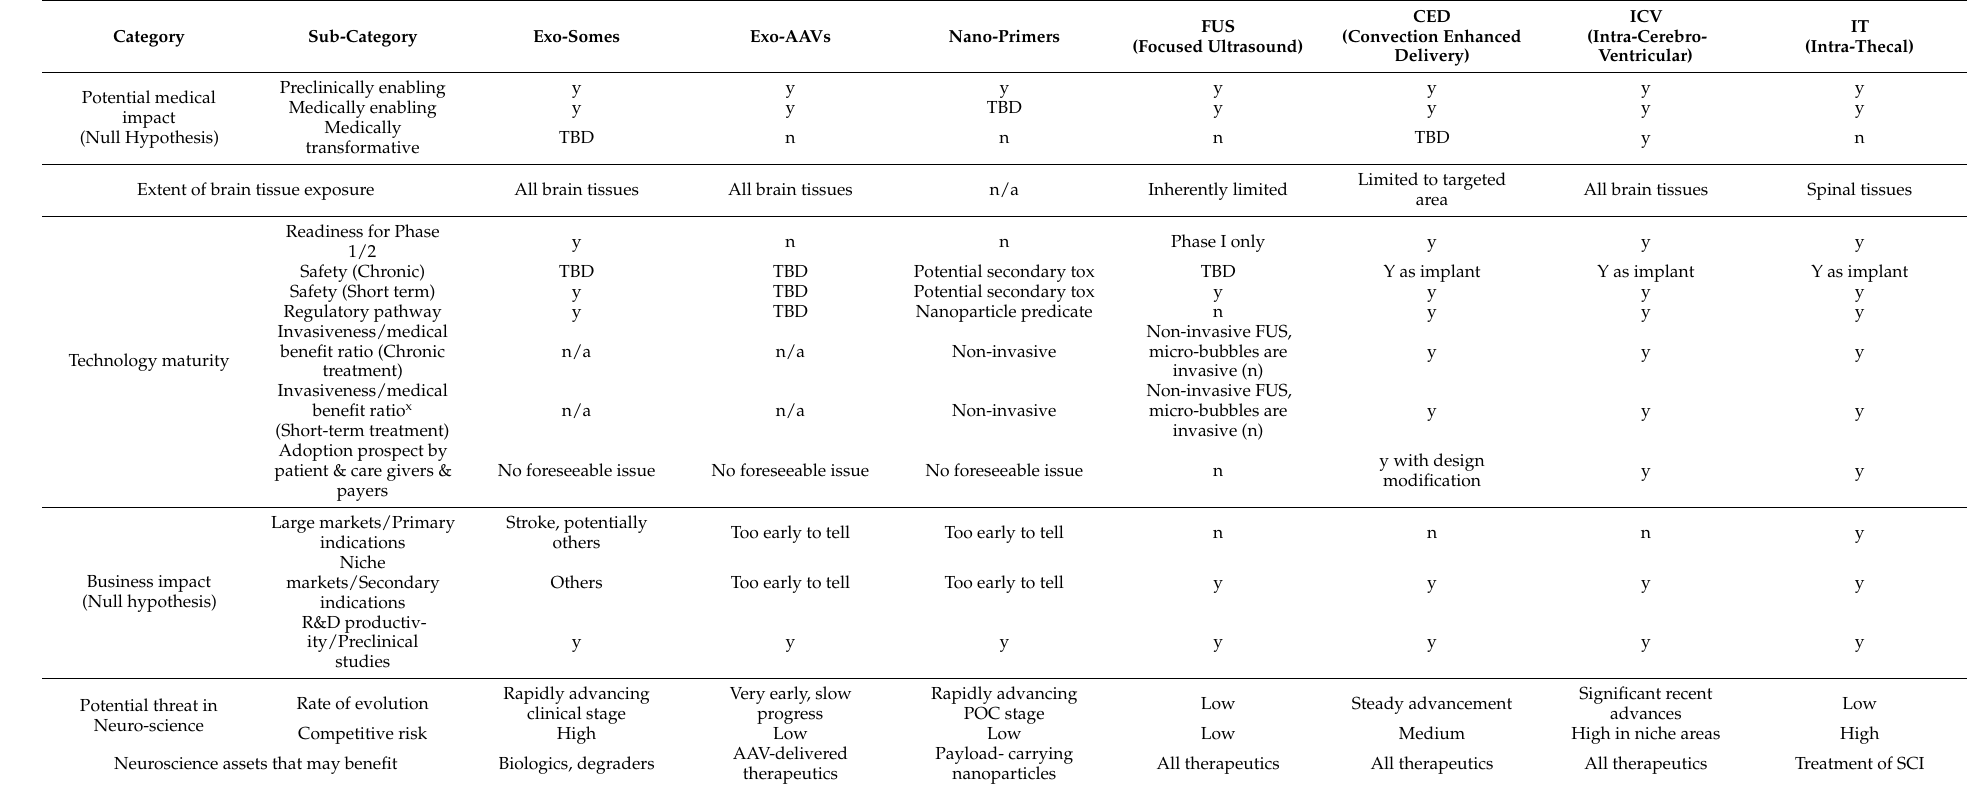
Table 7. Maturity and Potential Impact of “Brain-Biodistribution Enhancing” Technologies